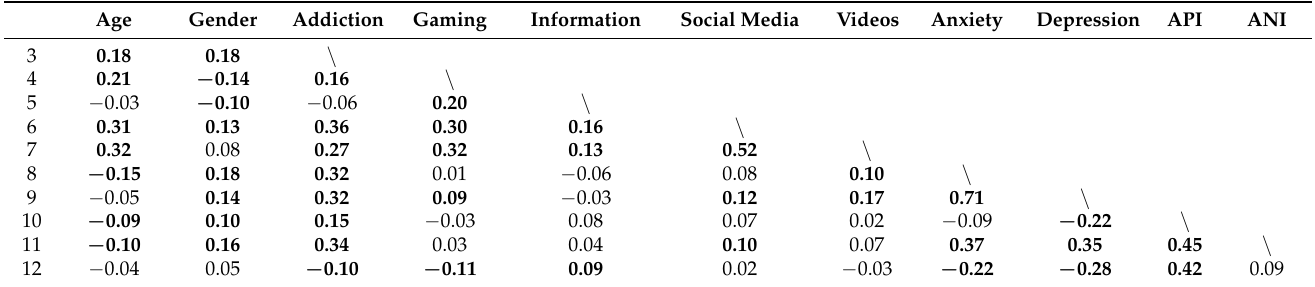
Table 2. Intercorrelations between the key